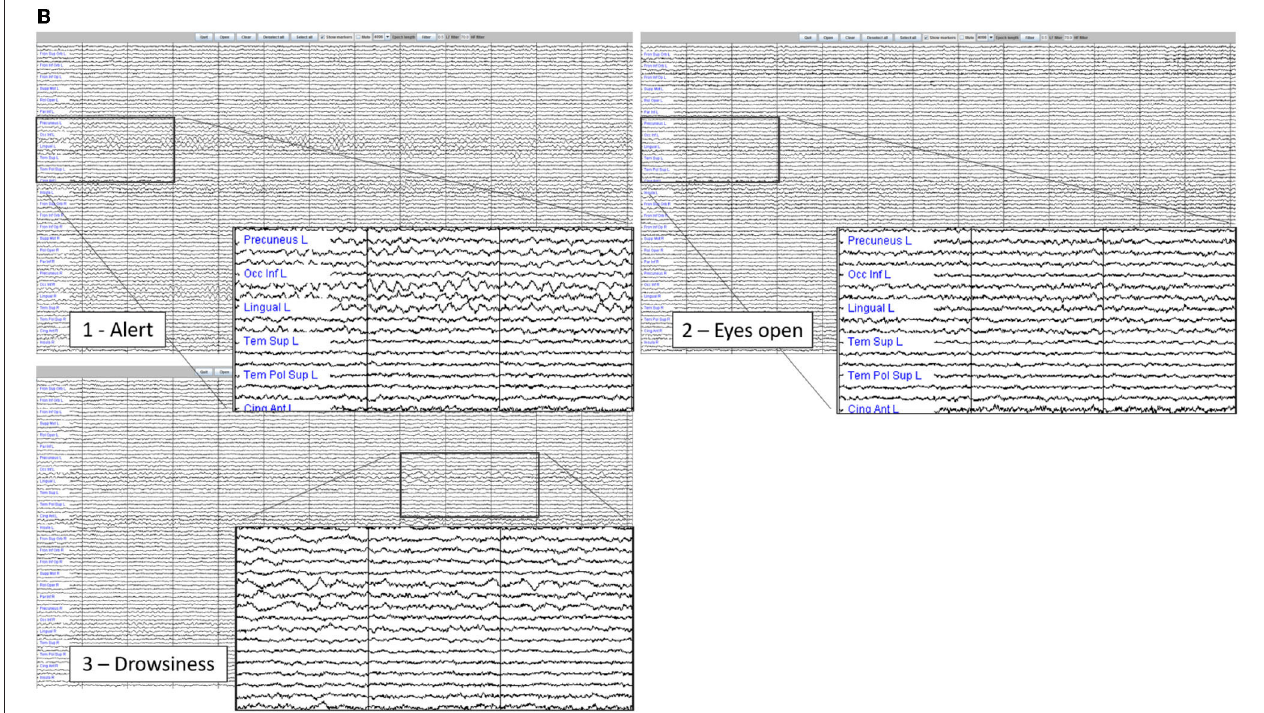
FIGURE 3 | (A) Representation of the state changes in subject one of the subjects. Note the changes in the power values depending on the presence of drowsiness, or visual suppression of the background pattern (epoch 28 in the eyes-open condition). Only epochs 21, 22, 24, 29, and 33 were without any signs of drowsiness. Epoch length was 13.1072s. (B) Source-space time-series visualized in Brainwave (epoch length 4,096 samples, sample frequency of 312Hz, resulting in an epoch length of 13.1072s). Shown are state changes in subject 7. Image 1 is epoch 29 of subject 7 (example of an A-EC epoch). In image 2 (epoch 28), the subject has opened the eyes (despite the instruction to keep them closed). In image 3 (epoch 30), there is clear slowing of the background pattern indicative of drowsiness/sleep. The magnifications show 3s of the AAL regions 21 (left precuneus) to 30 (left anterior